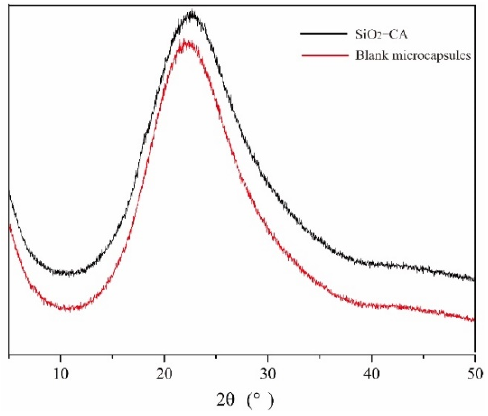
Figure 4. X-ray Diffractometer (XRD) patterns of SiO 2 -CA microcapsules and blank microcapsules.